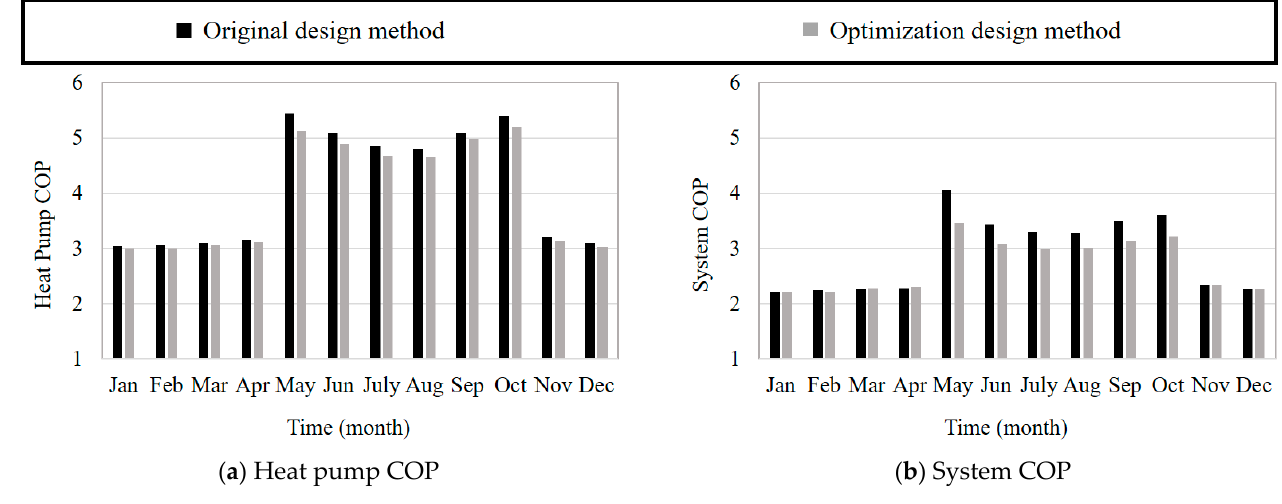
Figure 10. Results of HP and system performance; ( a ) HP COP of the system built with the existing and optimal capacity design methods, and ( b ) system COP.